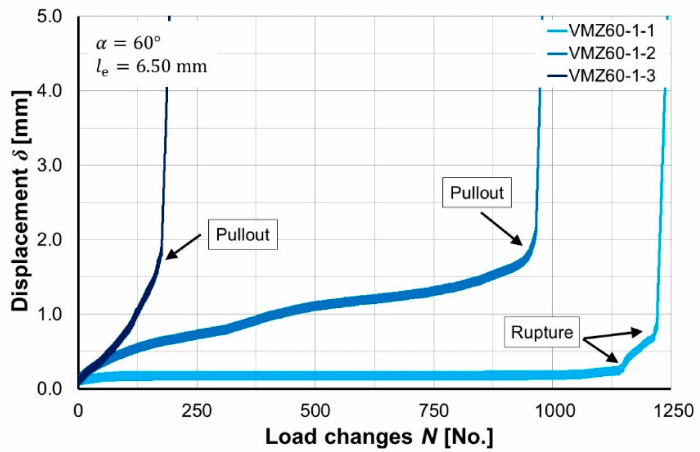
Figure 11. Pullout behaviour of steel fibre from UHPC under cyclic